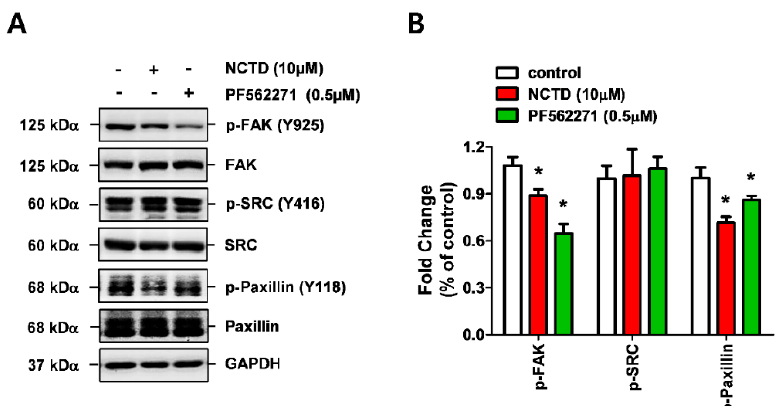
Figure 4. Comparison of the activation of FAK/Src/paxillin signaling between NCTD and PF562271 in YD-15 cells. ( A , B ) Western blot analysis of the phosphorylation of FAK/Src/paxillin signaling after the treatment with NCTD (10 μ M) or PF562271 (0.5 μ M) for 24 h. Graphs show the mean ± SD of triplicate experiments and significance compared with the vehicle control (* p < 0.05).